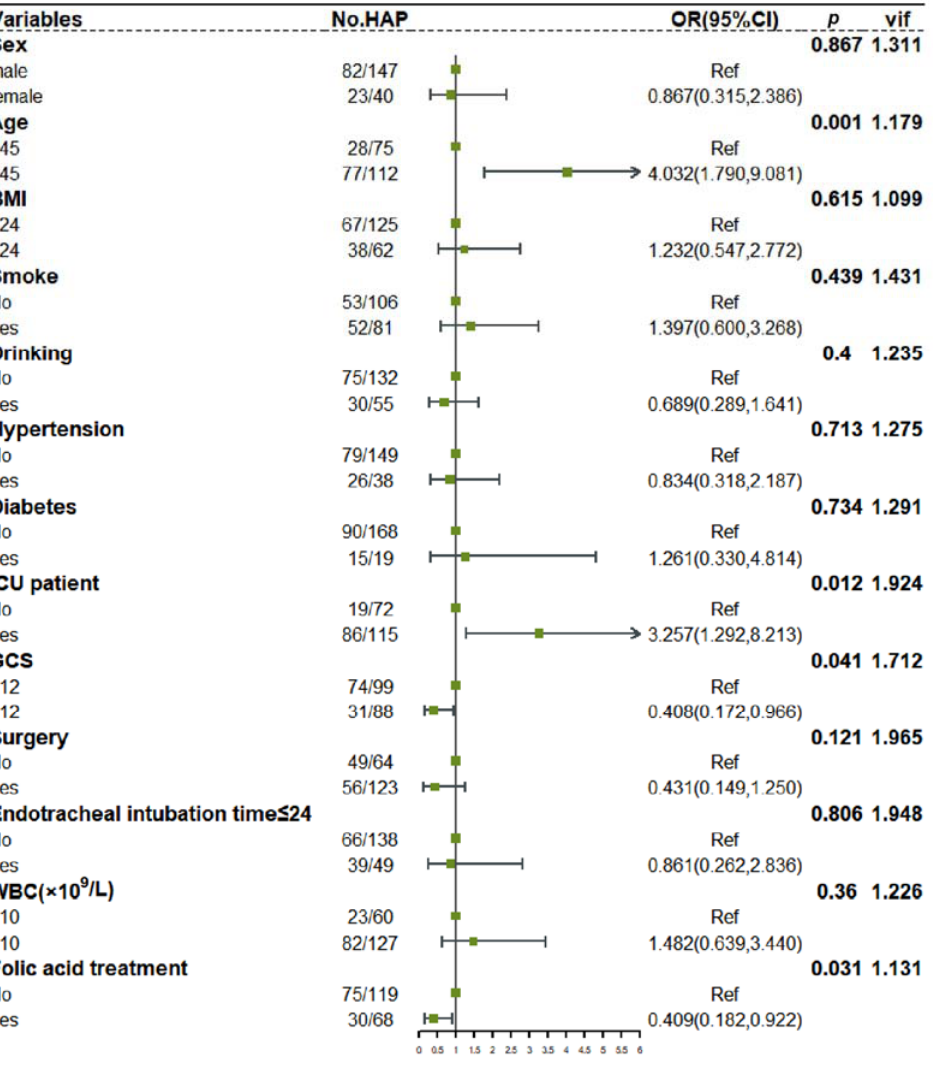
Figure 3. Multivariate logistic regression results and forest plot of the risk of HAP in TBI patients. Age > 45 ( p = 0.001), ICU patient ( p = 0.012), GCS ≤ 12 ( p = 0.041) and folic acid treatment ( p = 0.031) were independent risk factors for HAP in TBI patients.